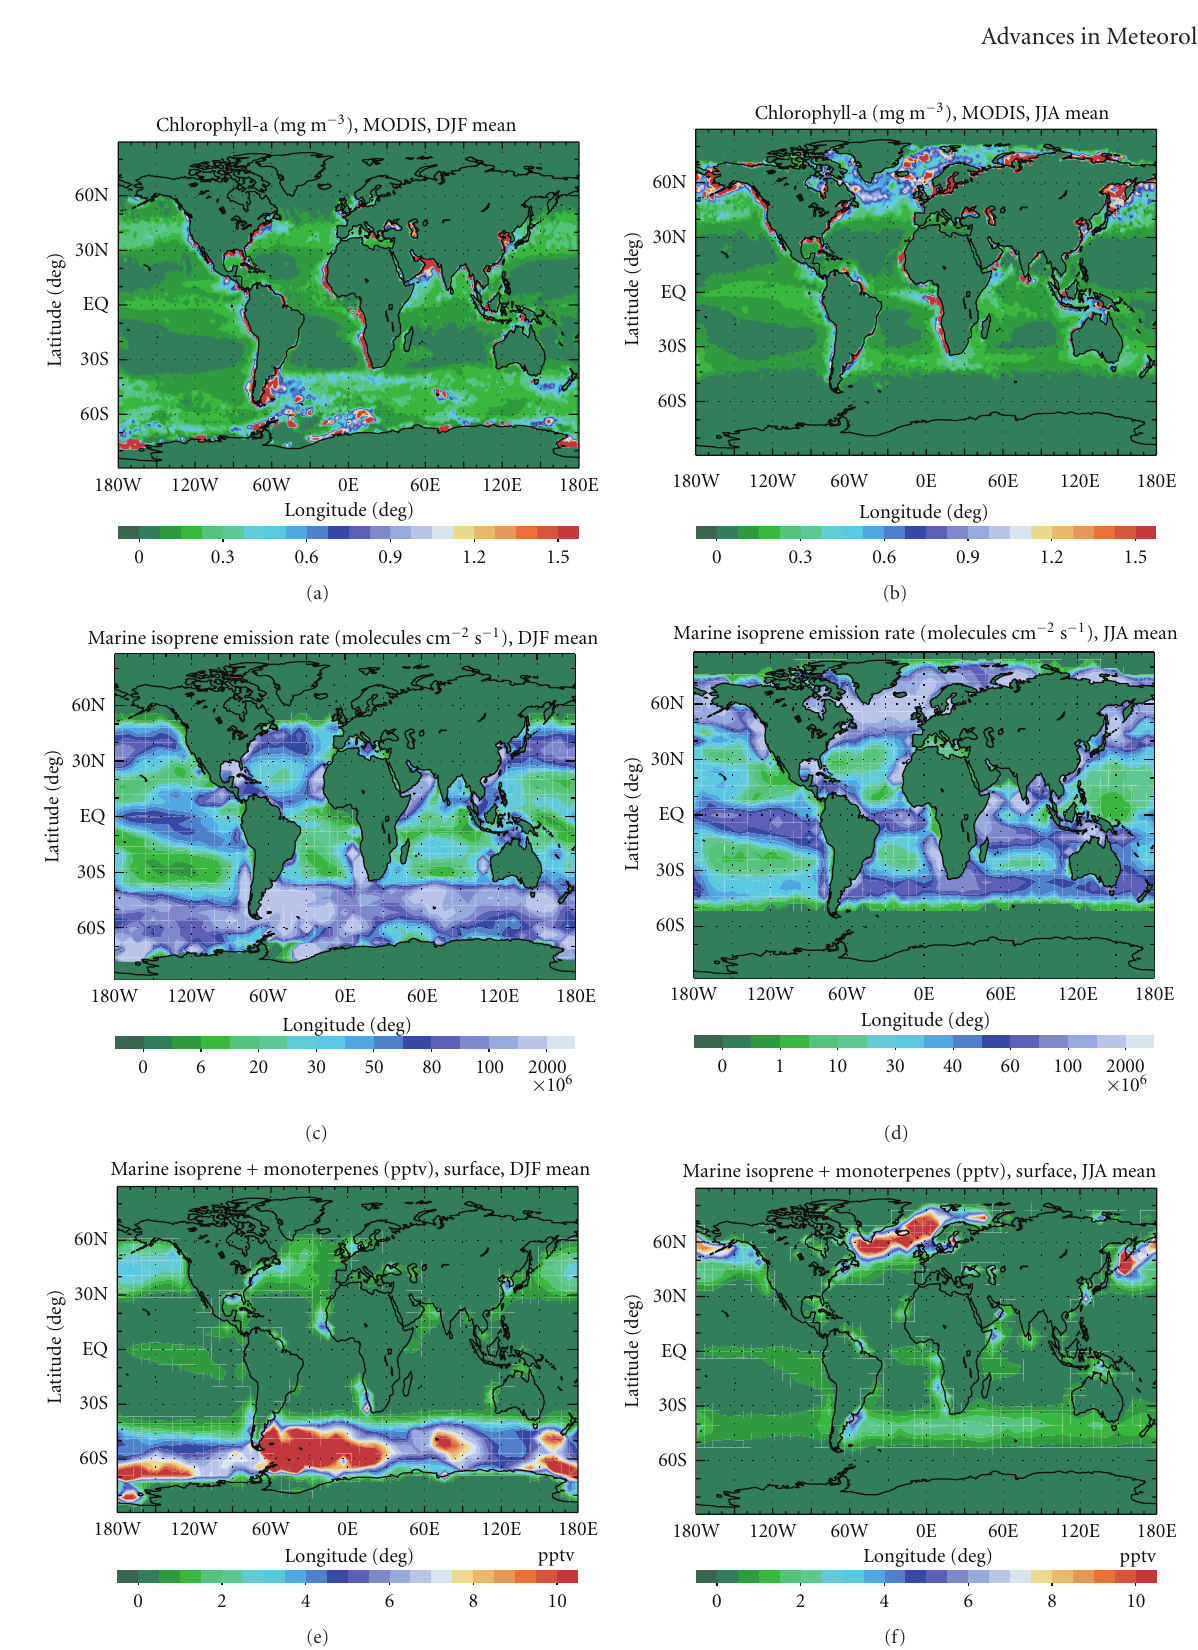
Figure 1: Seasonal mean surface distribution of Chl-a in mg m − 3 as retrieved from MODIS (see text) (a) for DJF and (b) for JJA; Marine isoprene emission rate in molecule cm − 2 s − 1 (c) for DJF (d) for JJA; Sum of marine isoprene and monoterpenes concentrations in pptv computed by the model (e) for DJF and (f) for JJA; for the year